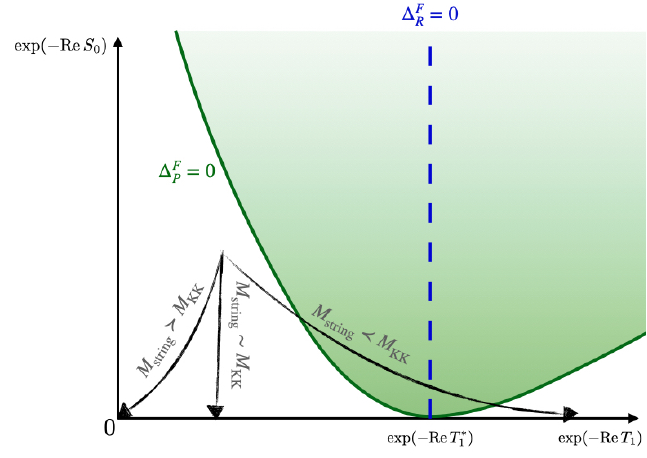
Figure 2 . This figure shows a sketch of the F-theory Kähler moduli space projected to the real part of the chiral fields for the example of B = P 2 . Shown are the two directions corresponding to the 2 (exponentiated) volume Re S of the exceptional divisor S and the volume Re T of pull-back of the 0 − 1 hyperplane H in P 2 to B . We also show the singularities whose existence we inferred from duality 3 to the heterotic GLSM parameter space. The projection of ∆ F = 0 to this plane is indicated by the P green solid line and corresponds to a strong coupling singularity for the E gauge group realized on 8 the exceptional divisor S whereas the singularity ∆ F = 0 (blue, dashed line) corresponds to the − R boundary of the Kähler cone. The region shaded in green corresponds to a strong coupling phase. In this figure, the Calabi-Yau phase of the perturbative heterotic string corresponds to the lower left corner. The intersection of ∆ F = 0 and S = ∞ is a point of tangency between ∆ F = 0 and 0 R P S 0 = ∞ . The arrows indicate the different types of classical infinite distance limits as in (4.43) (see also [15]) originating from a common point in the geometric